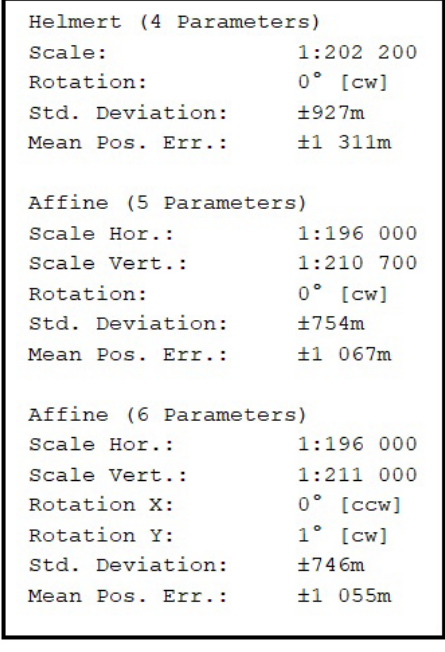
Fig. 7. The result layer attribute table of the algorithm and a report generated by MapAnalyst showing the generall scale of the old map depending on the applied transformation method (prepared by M.